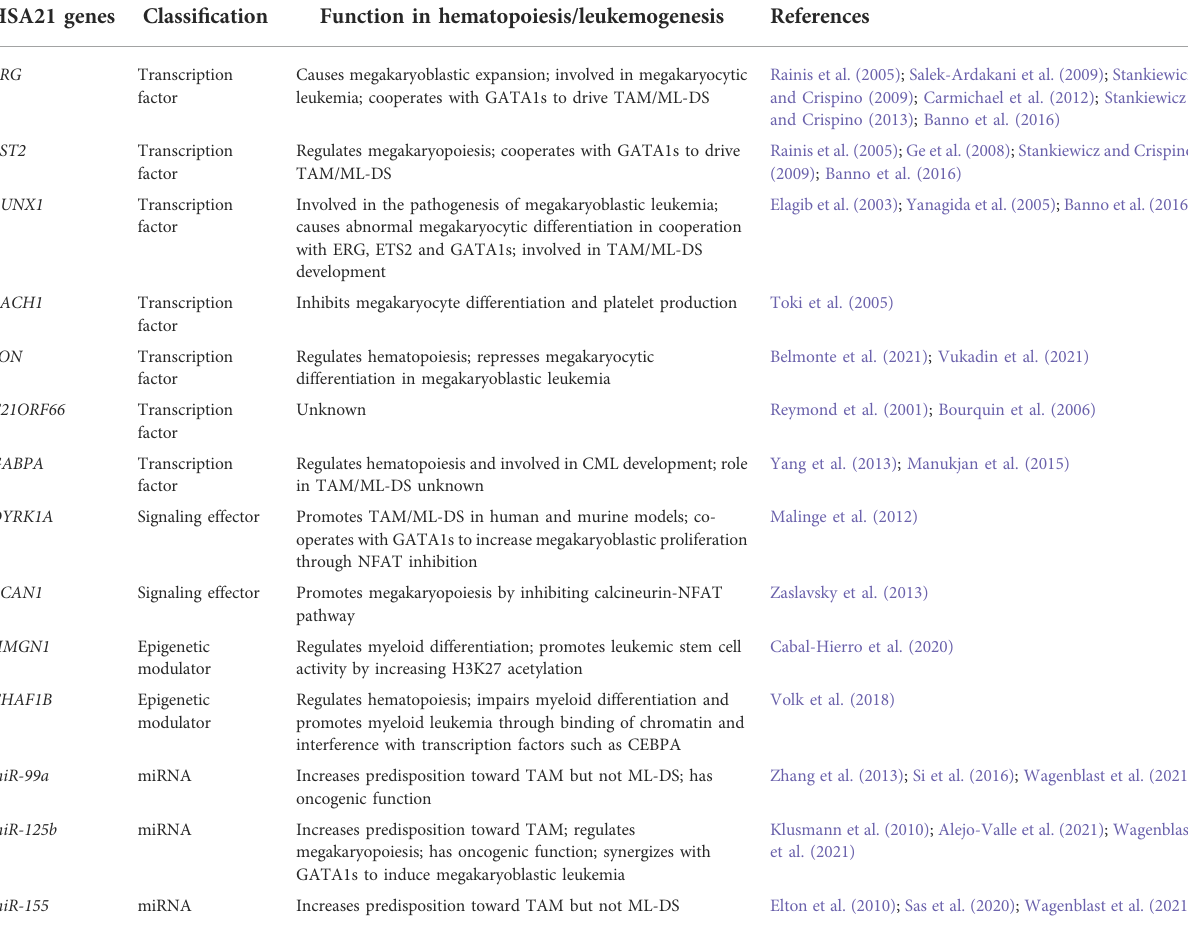
TABLE 1 List of HSA21 genes involved in myeloid proliferation associated with Down